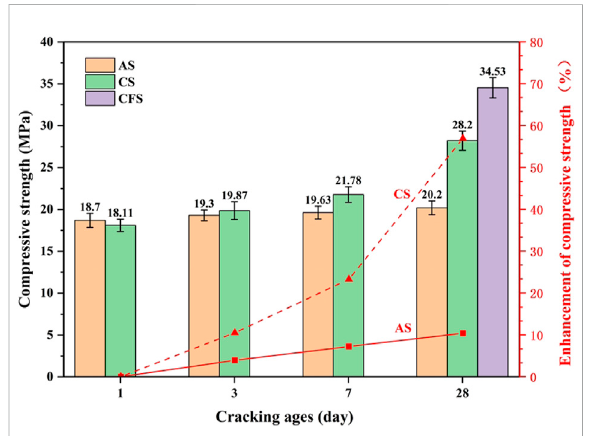
FIGURE 5 Compressive-strengthresultsfortheself-healingandcontrol samples (CFS: cracks free sample after 28 days of curing).